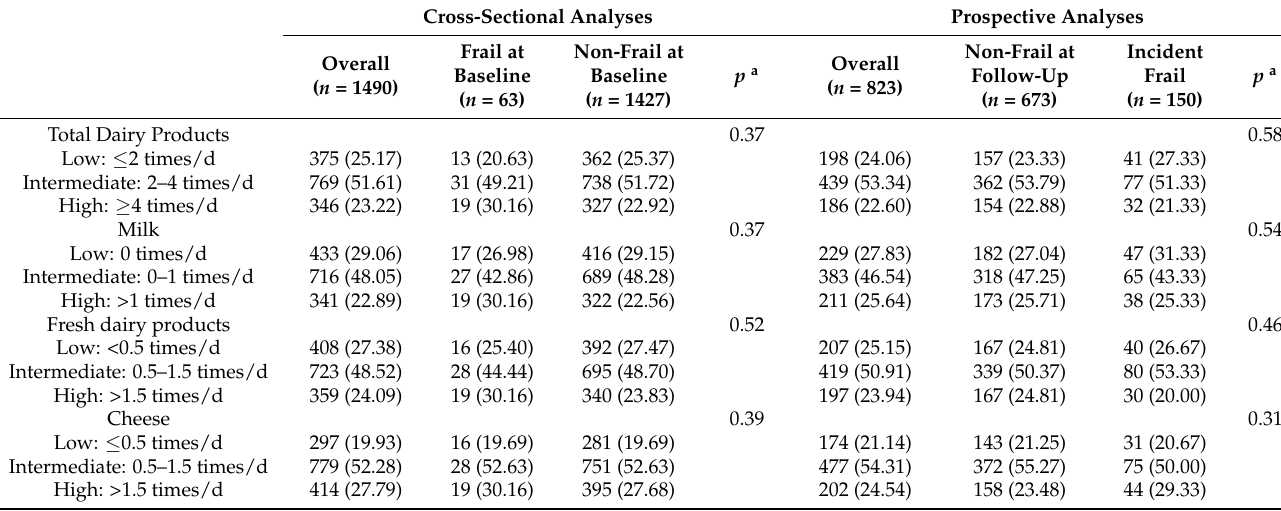
Table 2. Frequency of consumption of dairy products (total and sub-types) according to the frailty prevalence (cross-sectional sample, n = 1490 in 2000) and incidence (prospective sample, n = 823 between 2000–2010) of older adults from the Three-City study, Bordeaux